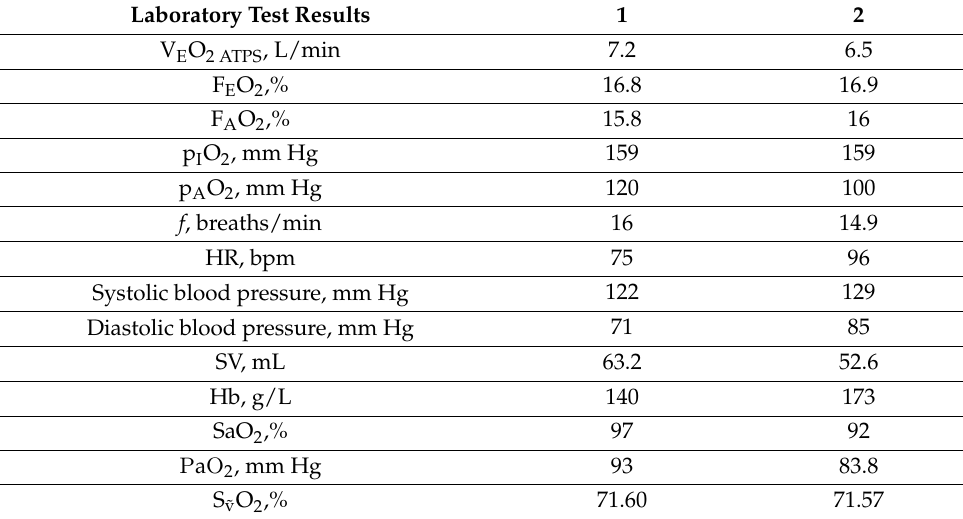
Table 2. Laboratory test results of the same person at normal body weight (1) and overweight